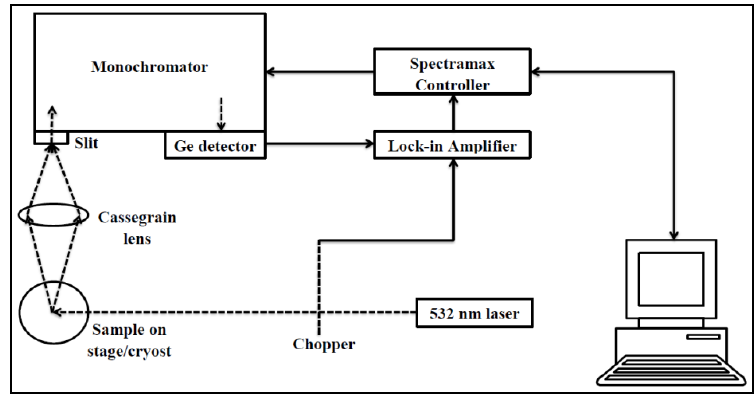
Figure 2. PL experimental setup. The samples were placed in the cryostat.